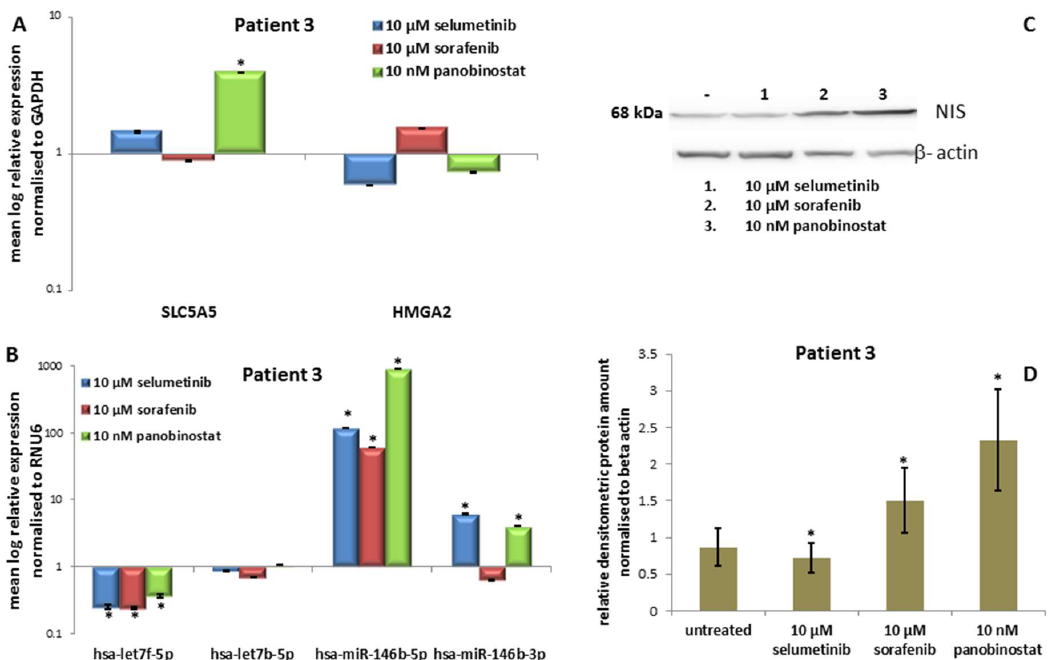
Figure 6. Effects of selumetinib, sorafenib and panobinostat on mRNAs, miRNAs and NIS protein expression in PDTT of patient 3 (ATC). RT-qPCR of NIS , HMGA2 ( A ), hsa-let7f-5p, hsa-let7b-5p, hsa-miR-146b-5p and hsa-miR-146b-3p ( B ). The expression was normalised to GAPDH ( A ) and